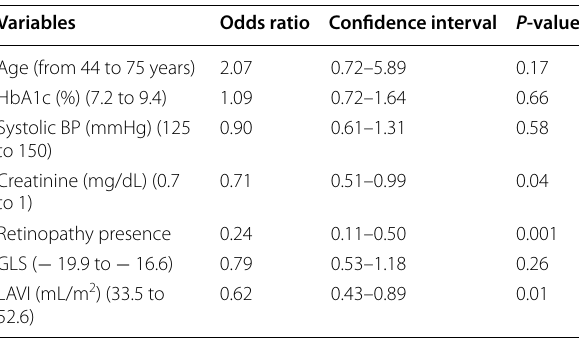
Table 4 Proportional odds regression model for predicting LA contractile strain